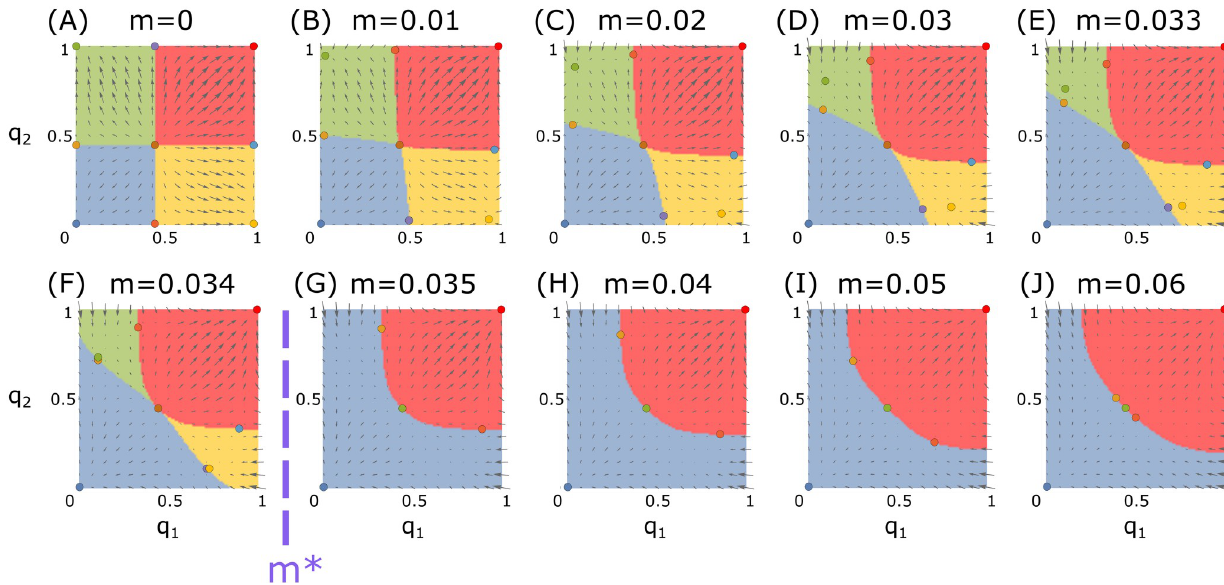
Fig 2. Equilibria and basins of attractions for different migration rates. Shown are results with a gene-drive configuration ( s , c , h ) of (0.6, 0.8, 0) (a configuration in B 2 ). The circles show the equilibria. The colored regions show the attraction basins, with the basin colors corresponding to the stable equilibria. The arrows show the vector field that describes the magnitude and direction of the change in allele frequencies at each point in frequency space. The differential-targeting equilibrium (DTE) is the stable yellow equilibrium point, which exists for migration rates lower than m � �